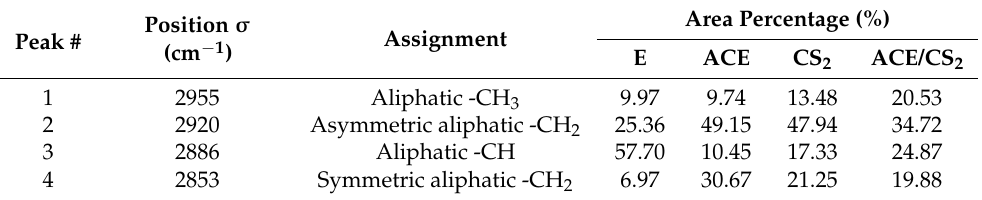
Figure 9. Infrared spectra of the original and extractive residues in the 2800–3000 cm − 1 region. (( a ) is an original tar residue fit, ( b ) is a fit to carbon disulphide, ( c ) is a fit to acetone and ( d ) is a fit to a mixed solvent. The red line is the fit line and the blue line is the sub peak). Table 9. Infrared spectra of four samples 2800–3000 cm − 1 split peak fitting ratio of each absorption peak area.